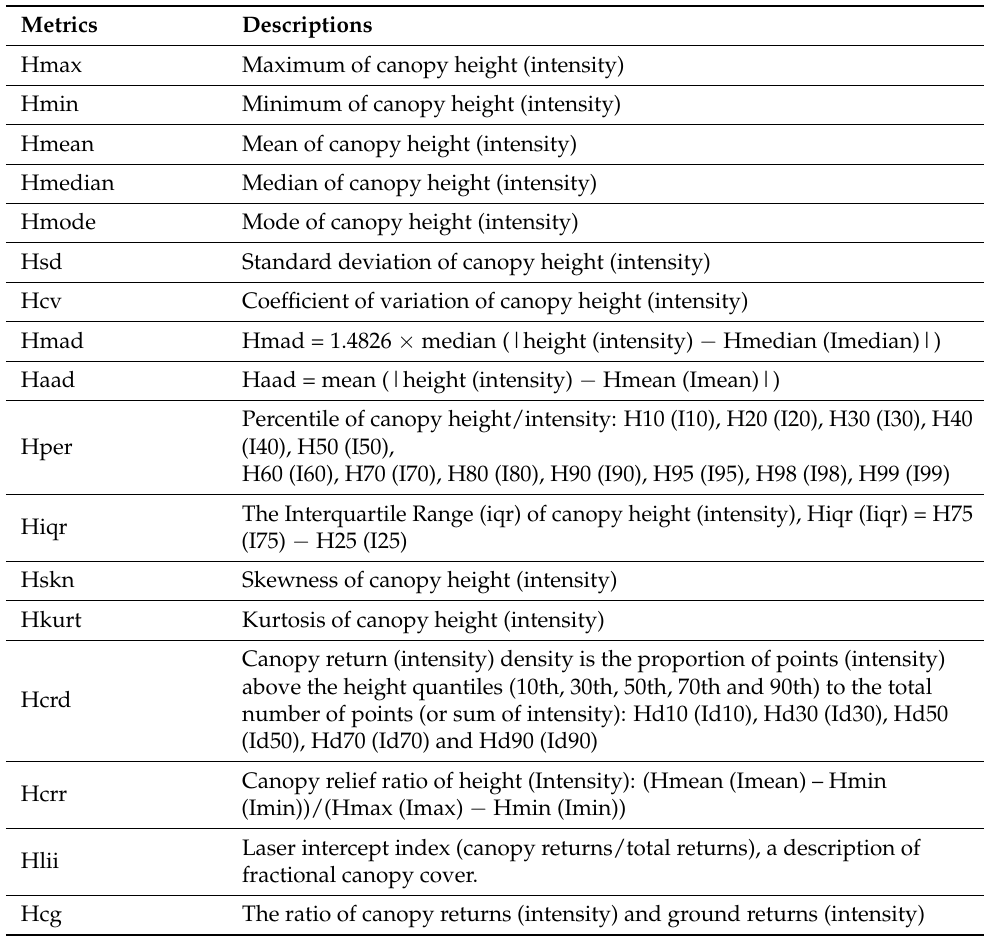
Table 5. LiDAR point-cloud-derived canopy structure